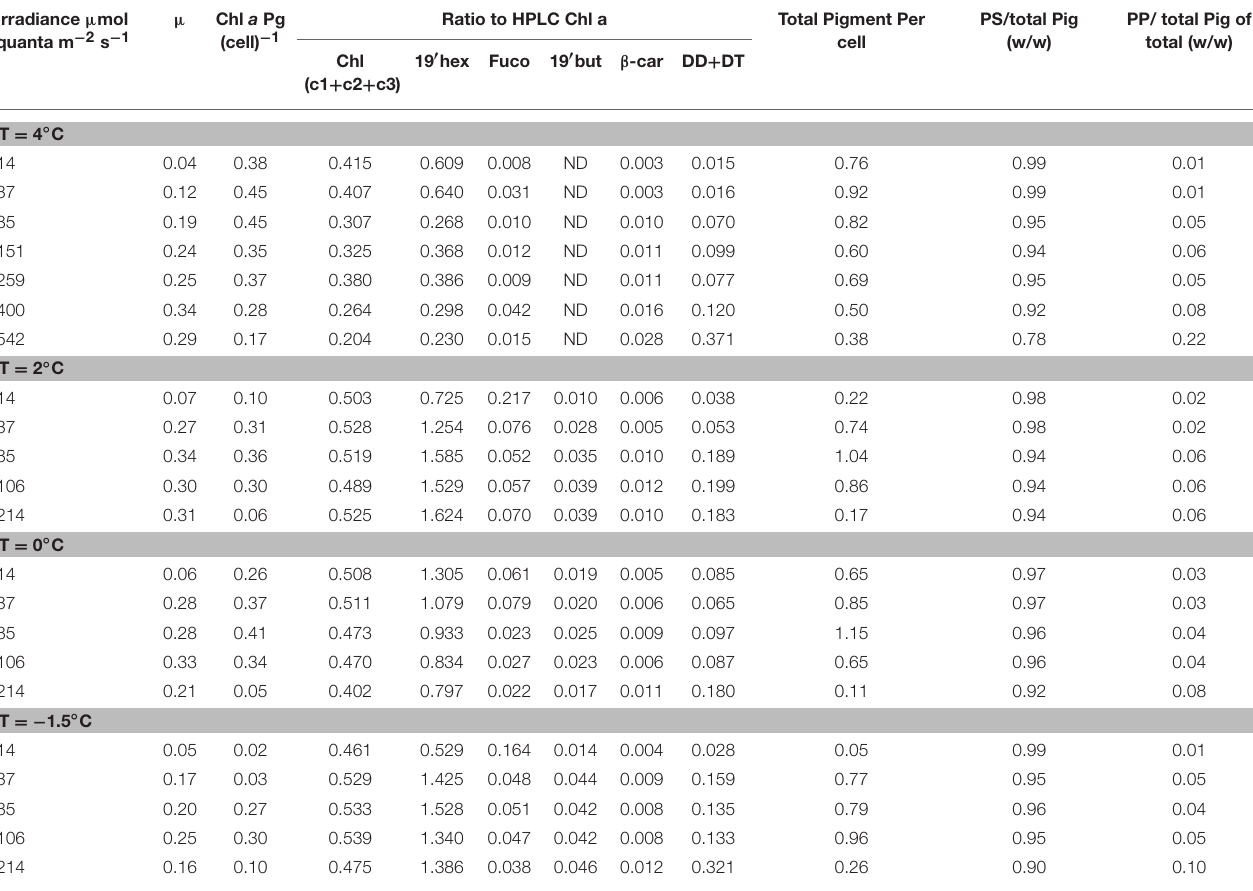
TABLE 2 | Growth and pigmentation of P. antarctica grown under nutrient-replete